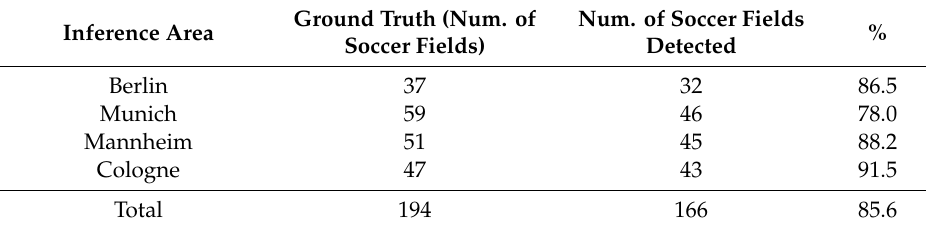
Table 3. Soccer fields identified by the